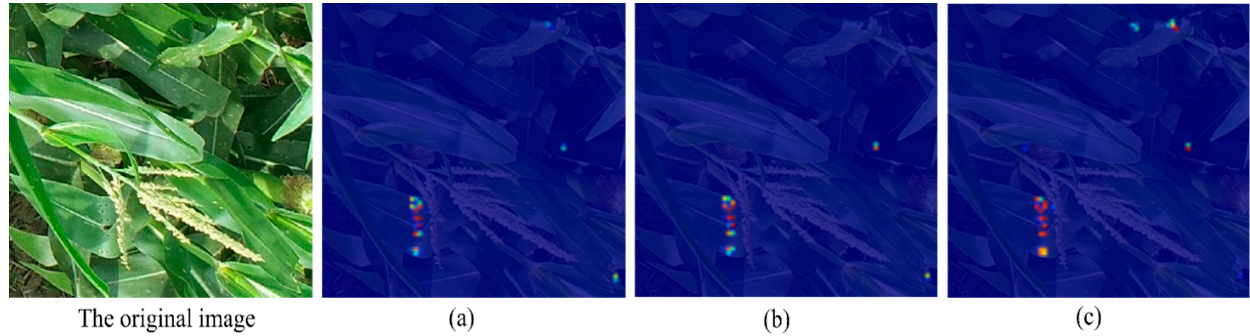
Figure 13. CAM visualization results; ( a – c ) are heat maps for YOLOv4, MA–YOLOv4, MAF–YOLOv4, respectively.